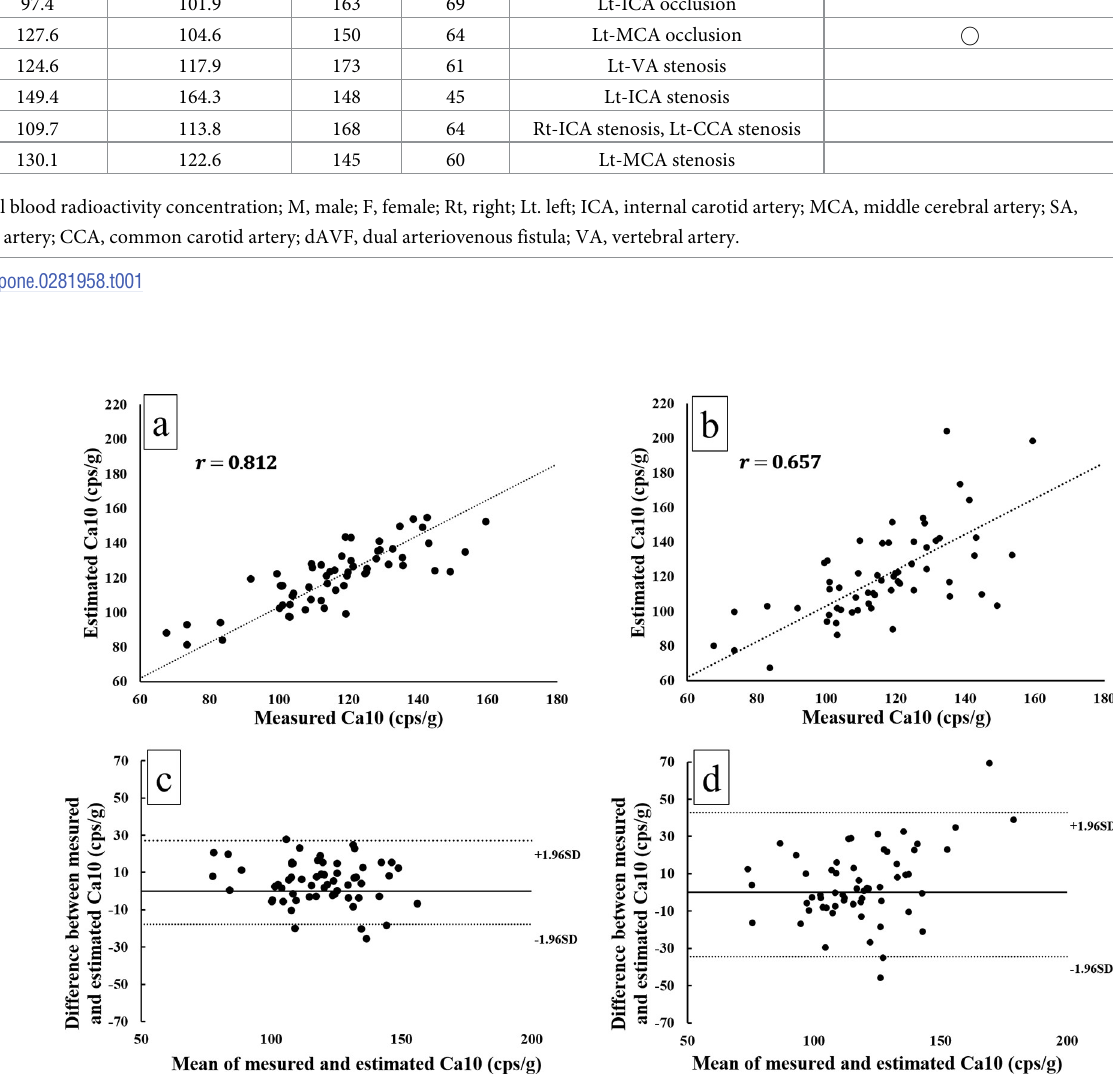
Fig 5. (a) Scatterplot with regression line between the true measured and estimated Ca10 by our proposed model revealed Pearson’s r-value of 0.81. (b) Bland–Altman plots of the differences versus the mean values between the measured and estimated Ca10 revealed that the short-dashed lines denote the 95% limits of agreement, and these values had a small and balanced dissemination. (c) Scatterplot with regression line between the true measured and estimated Ca10 by conventional method revealed Pearson’s r-value of 0.66. (d) Bland–Altman plots of the differences versus the mean values between the measured and estimated Ca10 revealed that these values had a relatively large and scattered dissemination.